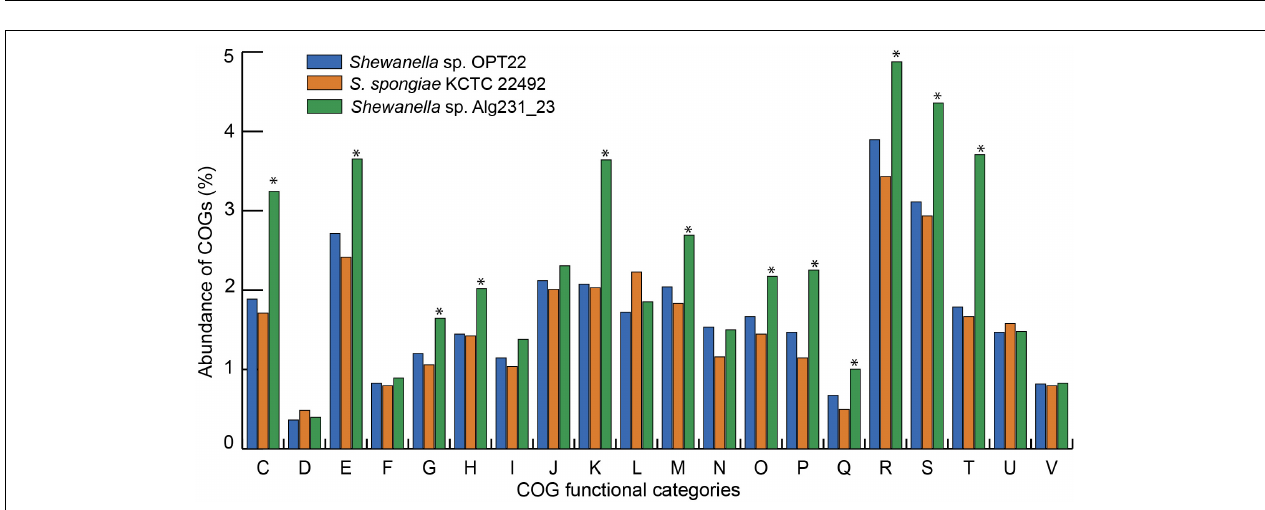
FIGURE 4 | Bar graph representing the relative abundance of COGs in each of the three sponge-associated Shewanella species. COG functional classes from C-V were shown. Shewanella sp. OPT22 sequenced in this study was represented in blue and other two genomes of sponge-associated Shewanella species- KCTC 22492 and Alg231_23 compared in this analysis were represented in light-brown and green, respectively. The asterisks denote significant abundance of COG categories ( p <